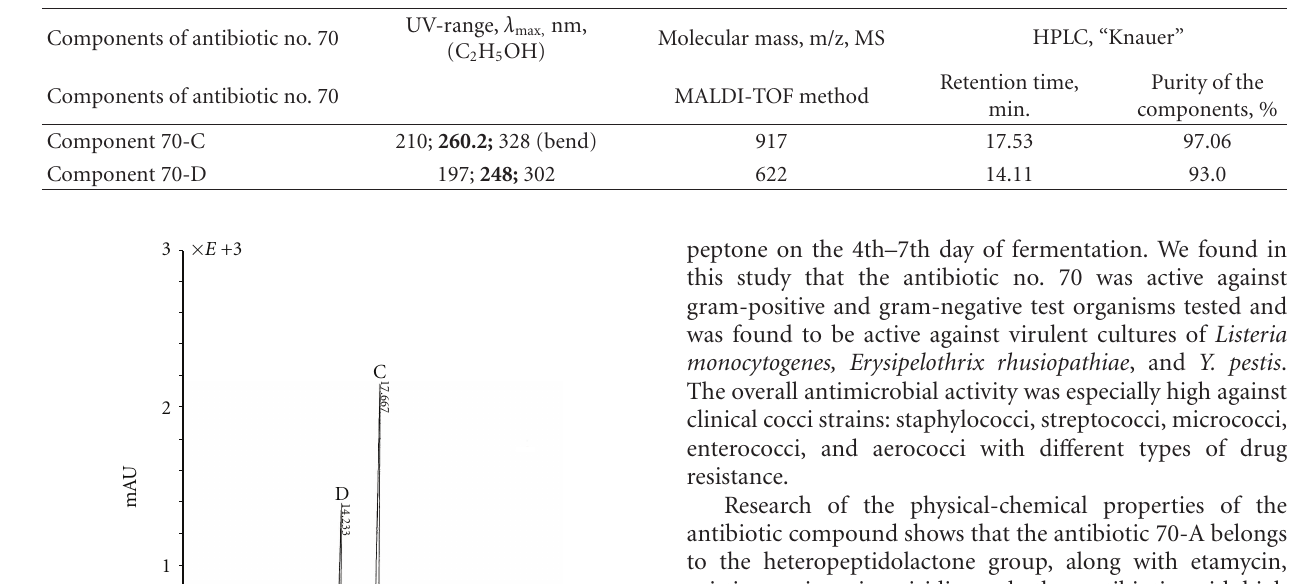
Table 3: Characteristics of certain minor components of antibiotic no. 70.